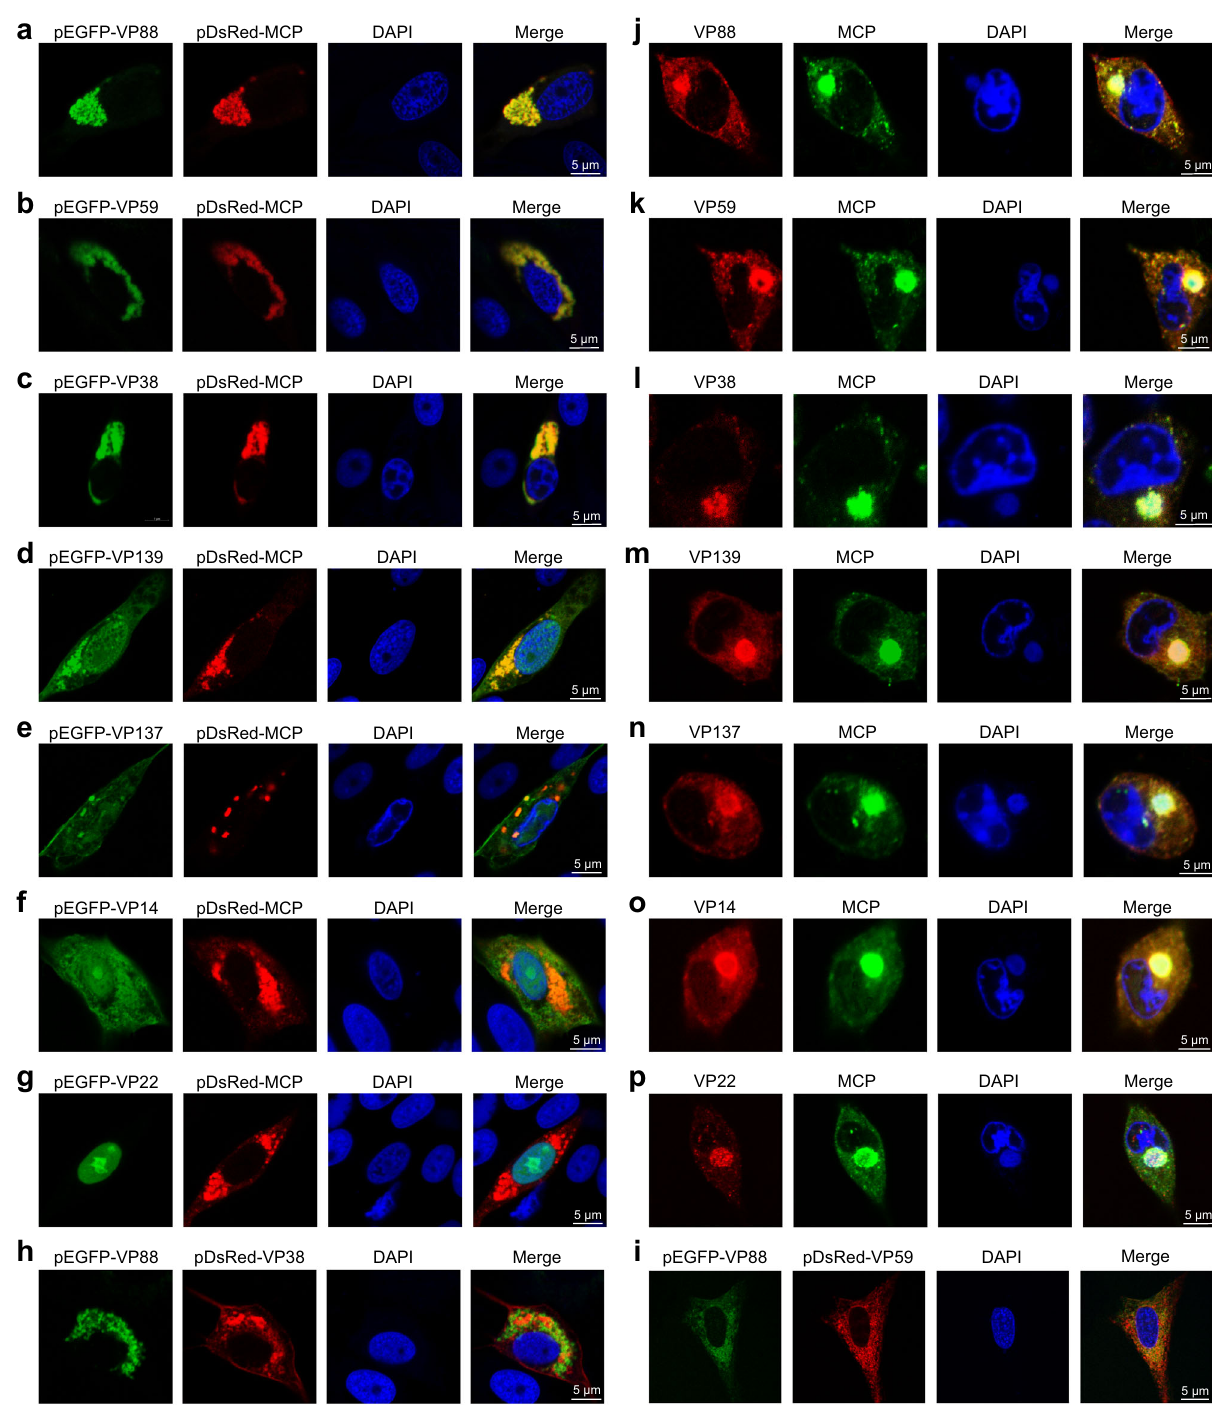
Fig. 4 | Colocalization between mCPs and MCP. Fluorescence colocalization assaysbetweenthemCPincludingVP88( a ),VP59( b ),VP38( c ),VP139( d ),VP137( e ), VP14( f ),orVP22( g )andtheMCPaftercotransfectionwiththerecombinantplasmid (pEGFP-VP88, pEGFP-VP59, pEGFP-VP38, pEGFP-VP139, pEGFP-VP137, pEGFP-VP14 or pEGFP-VP22) expressing the mCP fused to EGFP and the pDsRed-MCP plasmid expressing the MCP fused to DsRed into EAGS cells. Colocalization analysis between VP88 and VP38 ( h ), or between VP88 and VP59 ( i ) was performed as negative controls. Colocalization analysis between mCP including VP88 ( j ), VP59